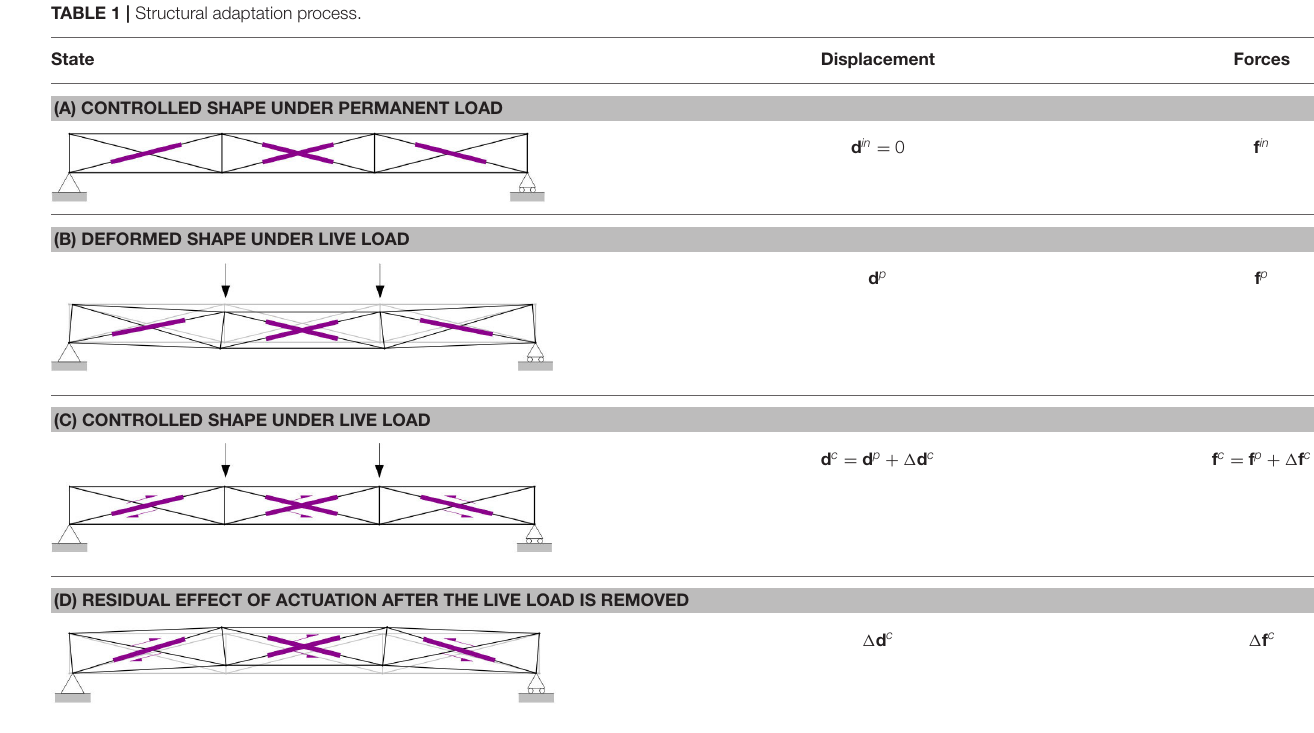
TABLE 1 | Structural adaptation